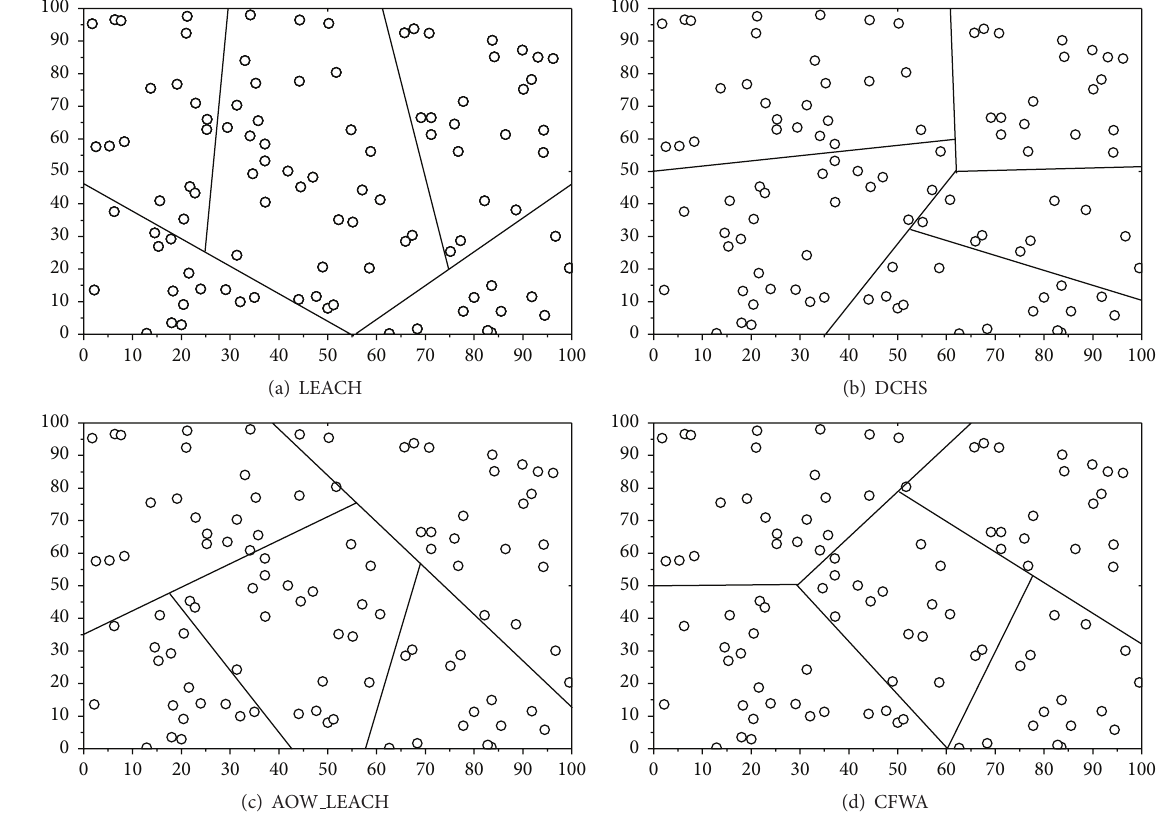
Figure 4: Cluster description comparison in a certain round.